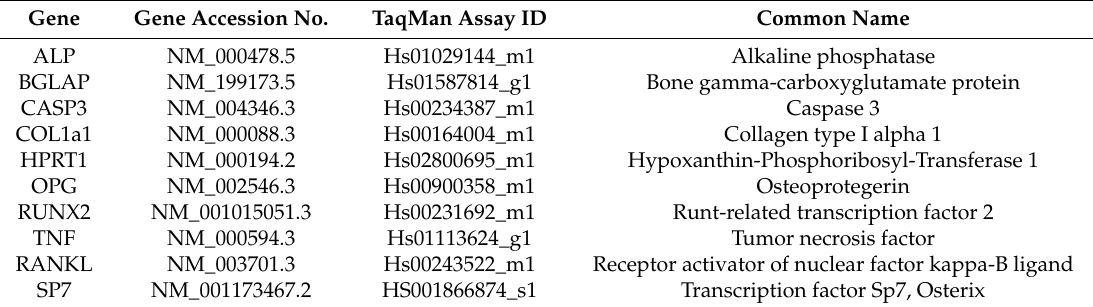
Table 1. The TaqMan probes and targets used. Probes were designed and tested for specificity by Life Technologies (Darmstadt,